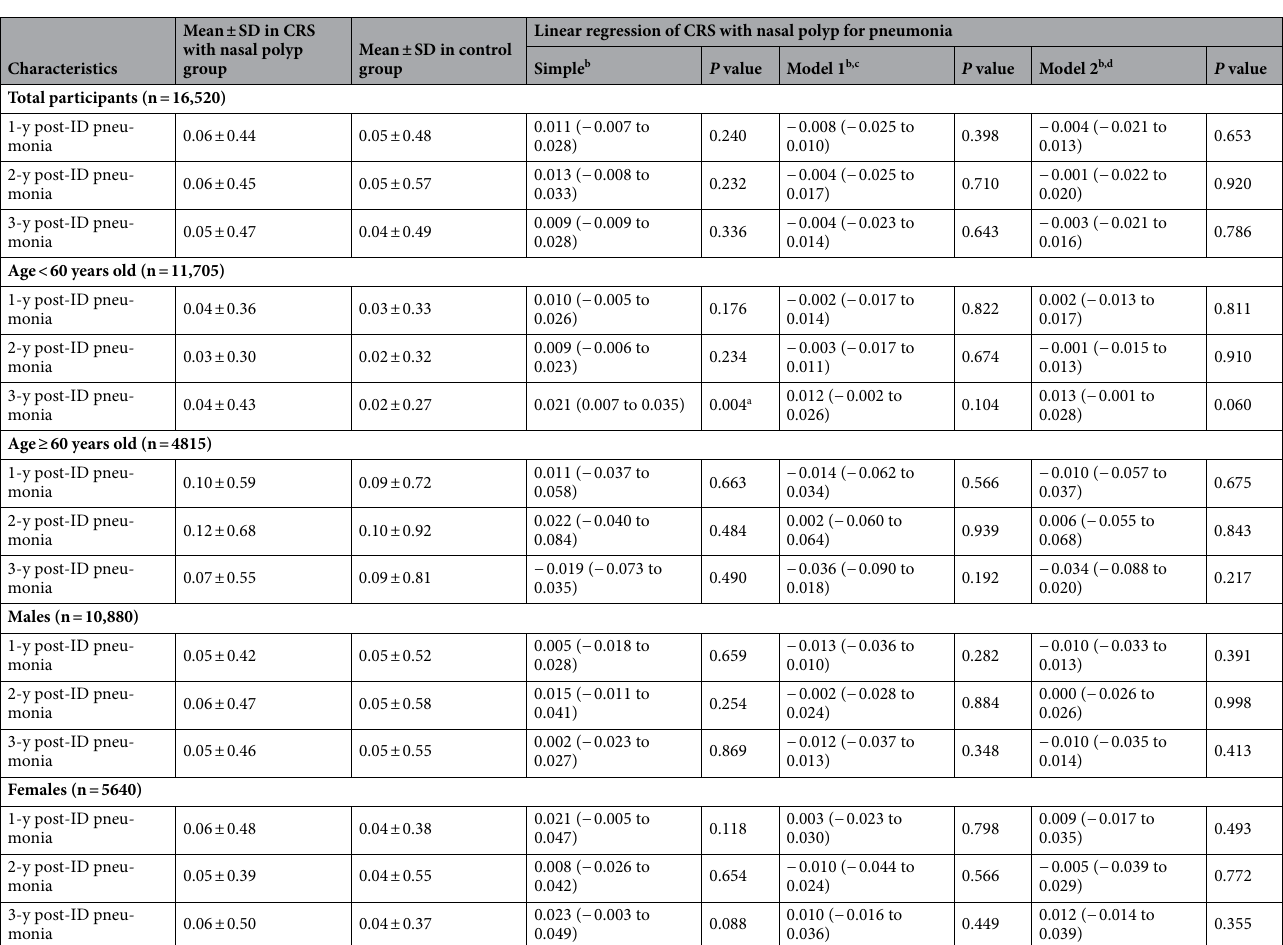
Table 3. Simple and multiple linear regression model (estimated value [95% confidence intervals]) for post index date of pneumonia (post-ID pneumonia) periods in chronic rhinosinusitis with nasal polyp compared to control group and subgroup analysis according to age and sex. Abbreviations: CCI, Charlson comorbidity index; COPD, chronic obstructive pulmonary disease; DBP, diastolic blood pressure; CRS, chronic rhinosinusitis; 1-y pre-ID pneumonia, pneumonia history from the date of CRS treatment (index date) to the date before 1-year periods; Post-ID pneumonia, the number of pneumonia diagnosis from the index date to the date after certain periods; SBP, systolic blood pressure; SD, standard deviation. a Linear regression